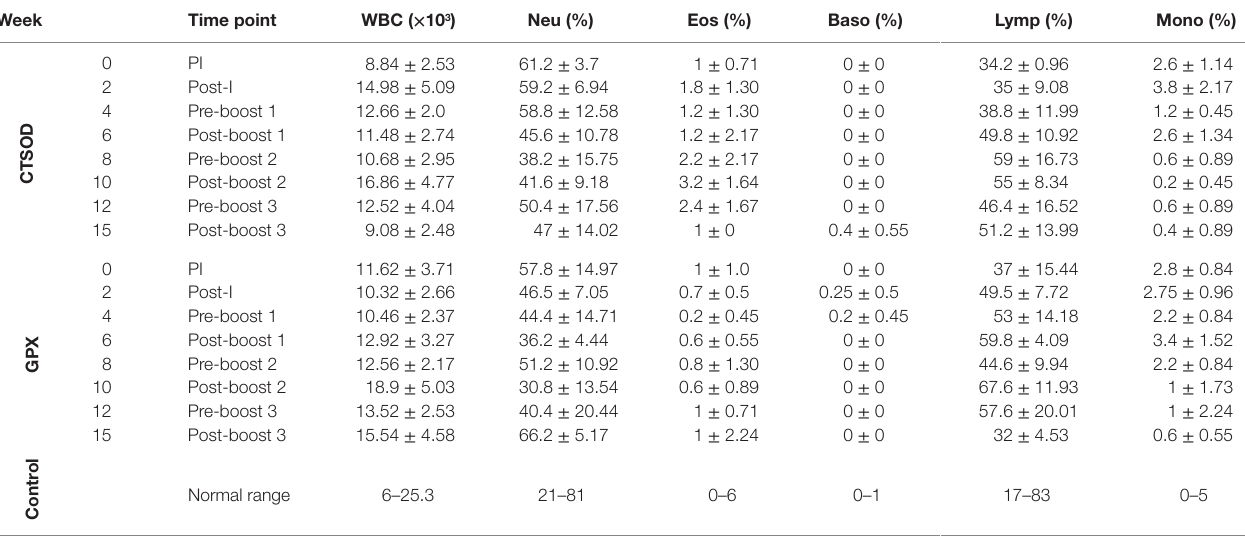
TaBle 1 | summary of effects of vaccination in baboons (experiment 1) a .